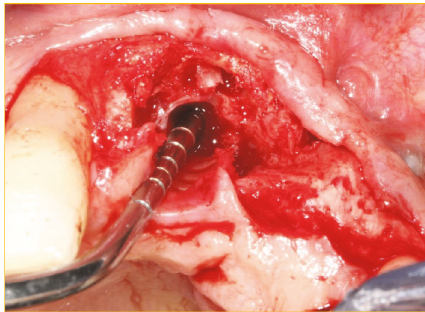
Figure 9: Probing of the implantotomy site to demonstrate that the apical portion was in the nonresistant nasopalatine canal.